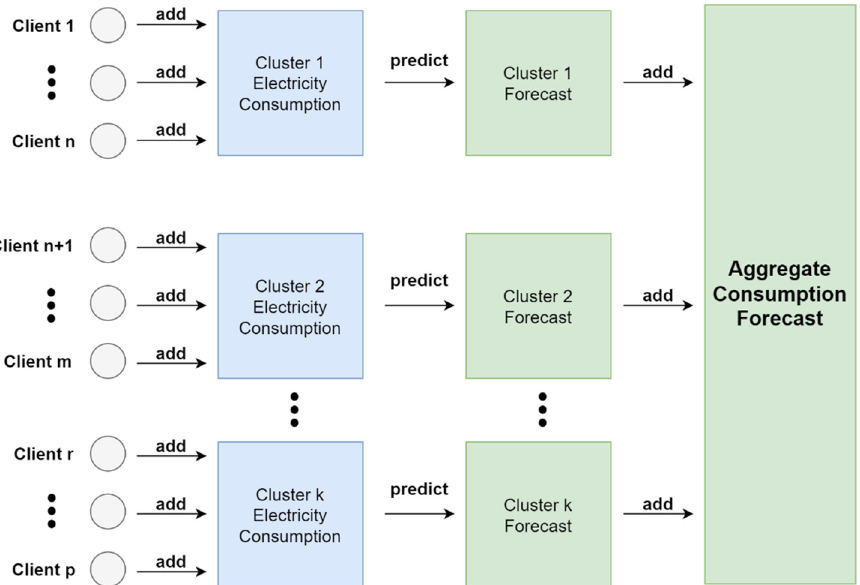
Figure 3. Cluster-based aggregate forecasting approach separating the consumer base into k clusters of variable sizes for the prediction of total electricity consumption.